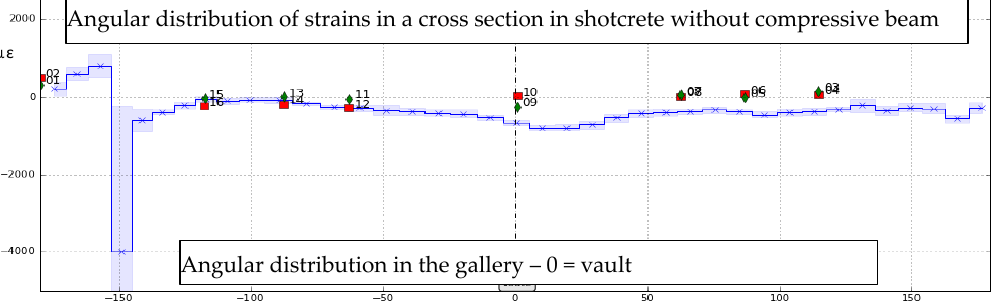
Figure 20. Strains measured by FOS (blue segments) and VWE (red squares for intrados location and green diamonds for extrados) around the cross section of the GER gallery (0 ◦ in vault and 180 ◦ in the bottom). FOS measured is the average stain over segments of 0.5 m. Blue line represents the moving window average of 12 h, with 95% confidence